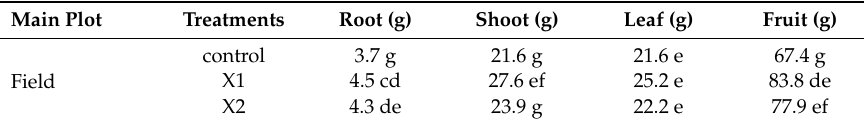
Table 3. Dry weights of root, shoot, leaf, and fruits at 70